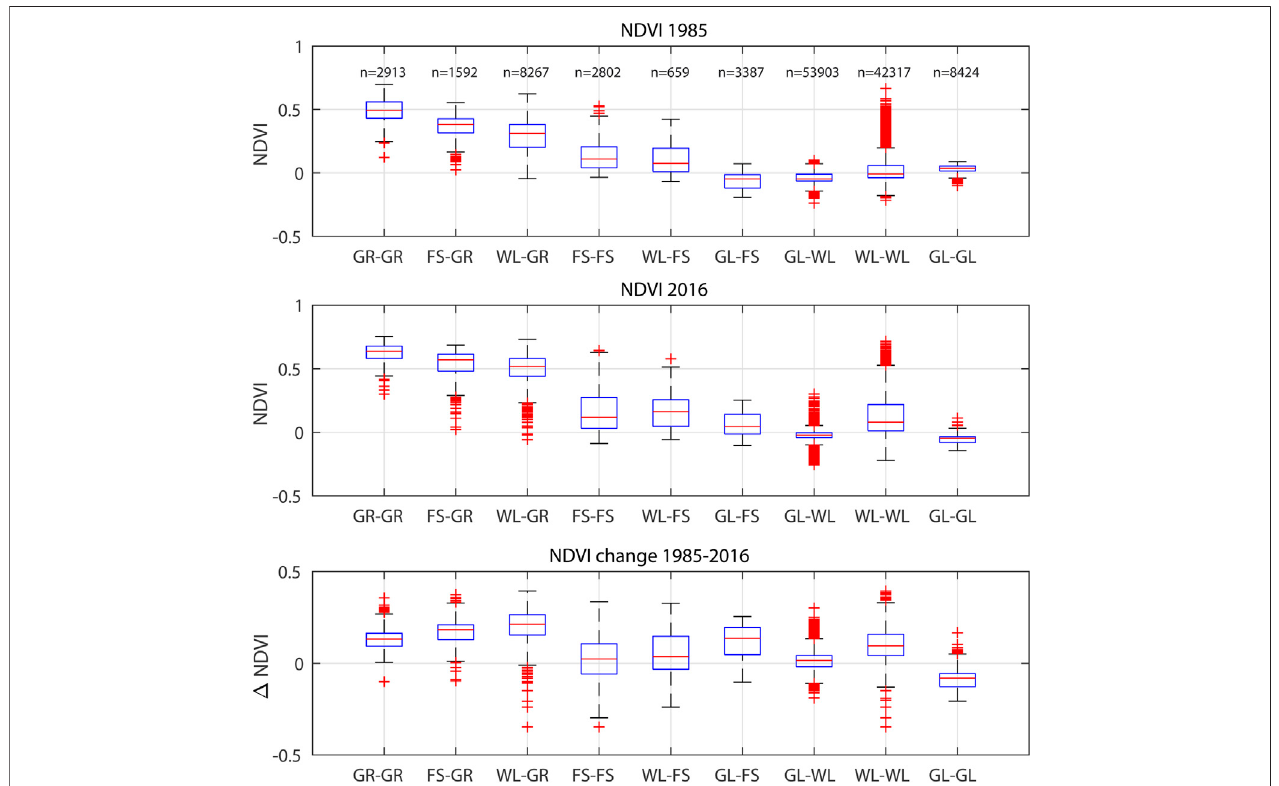
FIGURE8| “ NormalizedDifferenceVegetationIndex ” (NDVI)calculatedfortheproglacialzone oftheJamtalfernerin1985and 2016basedonFischeretal.(2019). Bottom graph: changes (difference) of the NDVI between 1985 and 2016. X-axes: raster cell transformations from land cover type in 1970 to type in 2015 (for abbreviations see Table 3 ; compare study area in Figure 1 ; n (cid:1) number of 5 m raster cells).